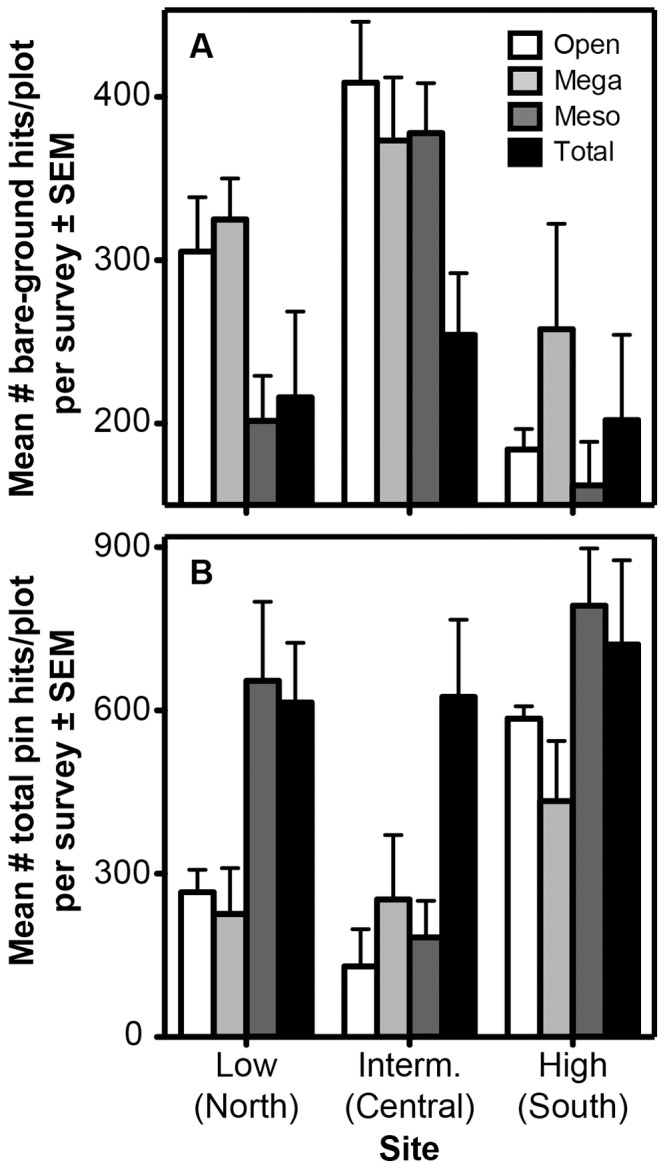
Trends in (A) extent of bare ground and (B) total understory vegetation pin hits across sites and treatments.Data are out of 490 total pin drops per plot per survey.